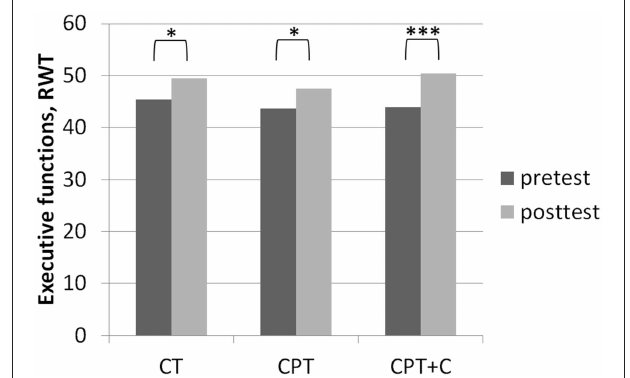
FIGURE 2 | Results of post-hoc analyses of within-subject factor Time for figural memory assessed with the Complex Figure Test (CFT) as described in Strauss et al. (2006) in each training group separately. *** p ≤ 0.001 .